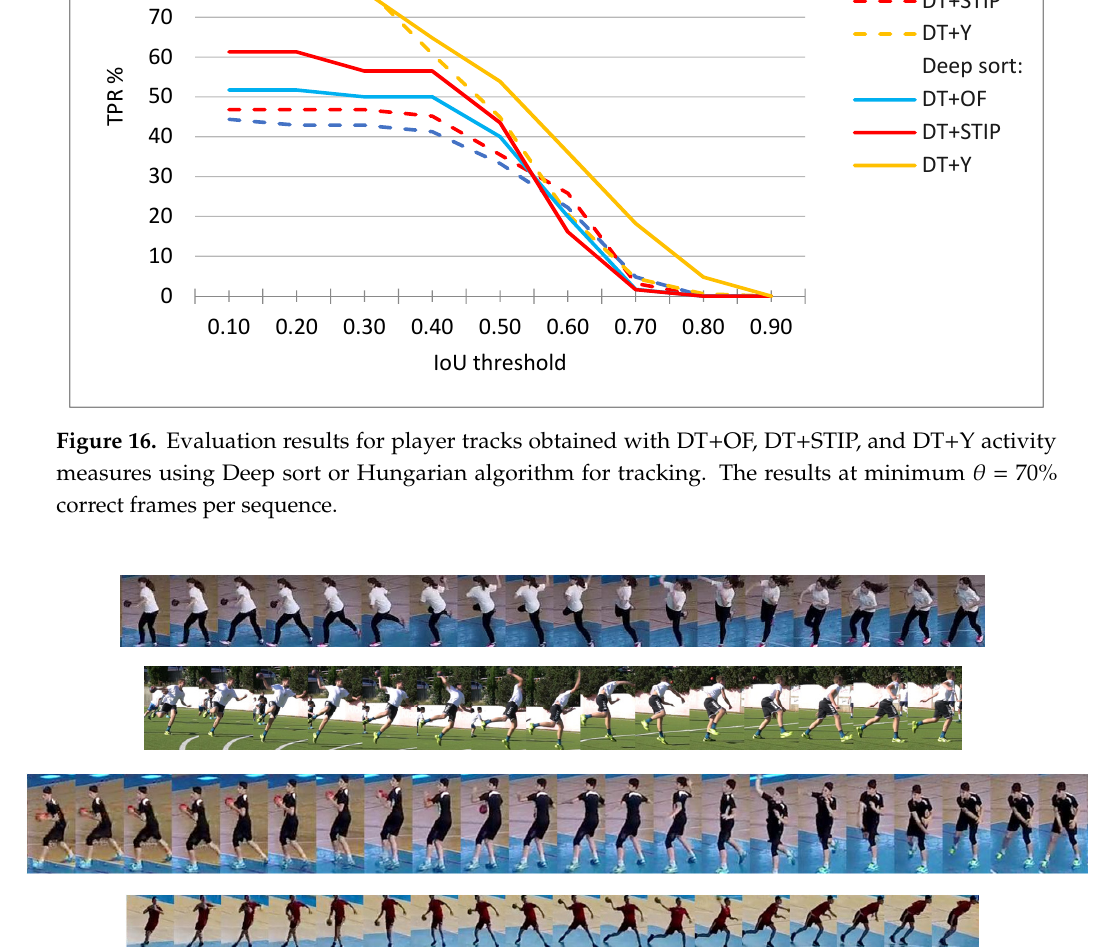
Figure 19. Tracking errors due to poor player detection. Figure 20 shows a negative example of an active player's track due to improper tracking of players occurring due to cluttered scenes, players overlapping, or changing position. Figure 20. Examples of tracking problems. A detector detects all players on each frame and the activity level is calculated for each one and their movement is monitored and recorded. The proposed method will select the player with the highest level of activity in most frames as the most active player; however, it is possible that the most